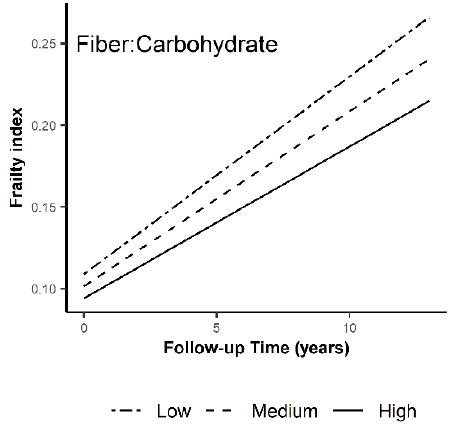
Figure 2. Trajectory of FI in the tertiles of fiber-to-carbohydrate ratio in women. Association between baseline consumption of fiber-to-carbohydrate ratio was evaluated using linear mixed effects model. Among women, those in the highest tertile of fiber: carbohydrate experience significantly less steep increase in FI compared to those in the lowest tertile.